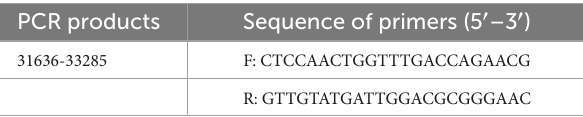
TABLE 3 List of primers for detecting recombinant virus. PCR